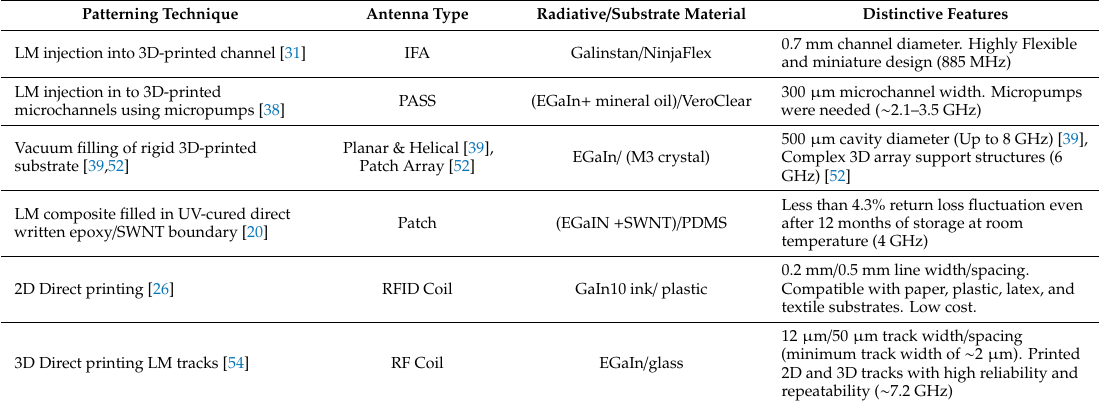
Figure 6. ( a ) Developed 3D printer; ( b ) relation between 3D-printed EGaIn linewidth and printing speed; ( c ) relation between printer’s nozzle diameter and printed line width; ( d ) schematic of reconfigurable RF antenna coil; ( e ) schematic and SEM image of fabricated antenna with disconnected and ( f ) connected inner/outer coils (scale bar was 300 μ m); and ( g ) corresponding variation in reflection co-efficient of reconfigurable antenna in both states [54]. Table 3. LM Antenna patterning techniques based on printing / direct writing fabrication methods. Abbreviations: IFA, inverted-F antenna.